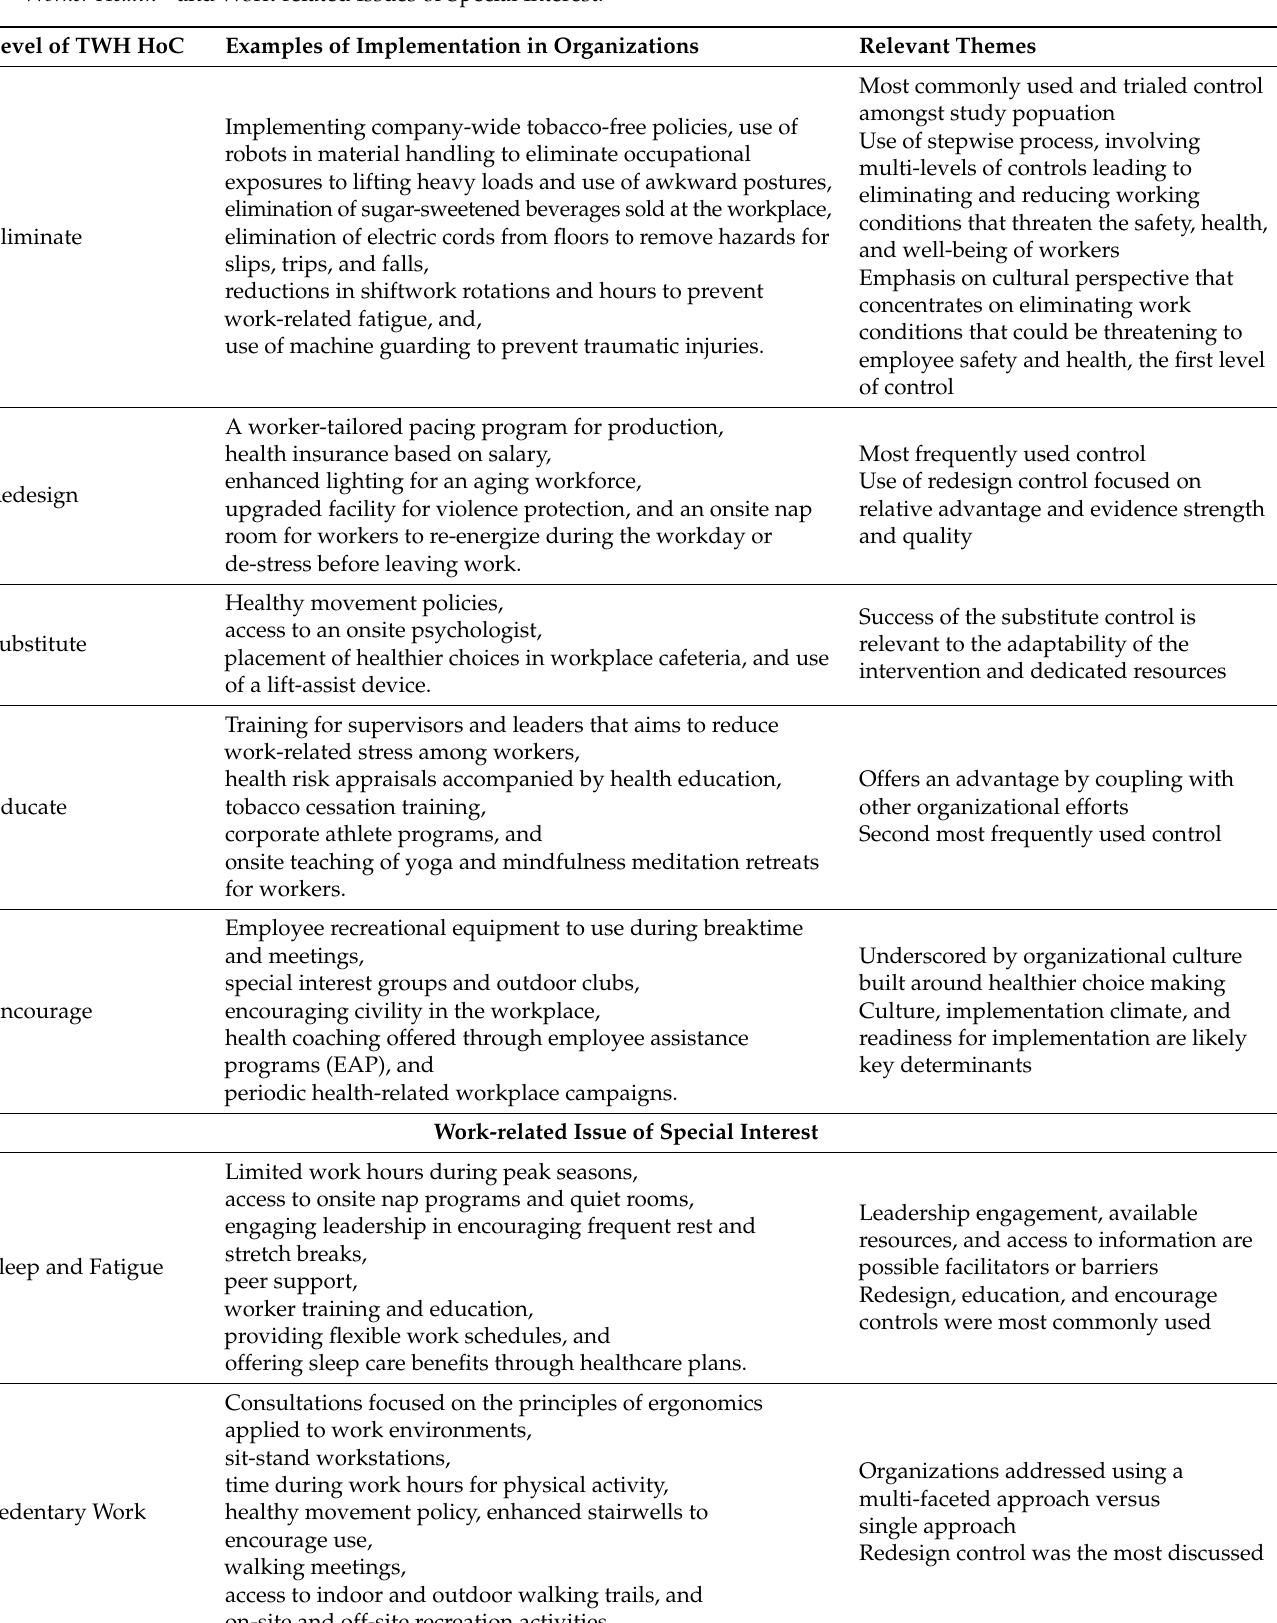
Table 3. Summary of Key Results According to Levels of Controls in the Hierarchy of Controls Applied to NIOSH Total Worker Health ® and Work-related Issues of Special